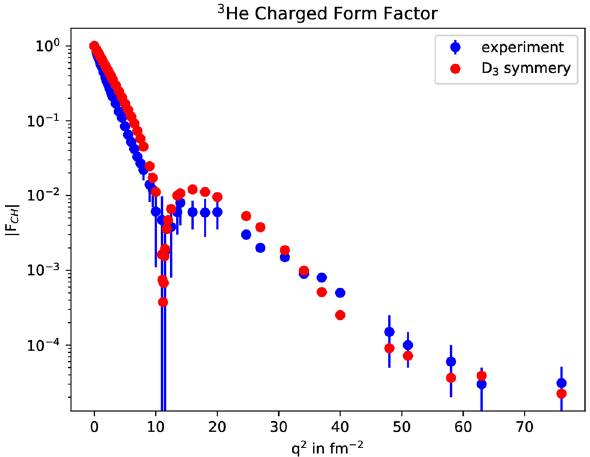
Figure 2. Equilateral triangle scattering of